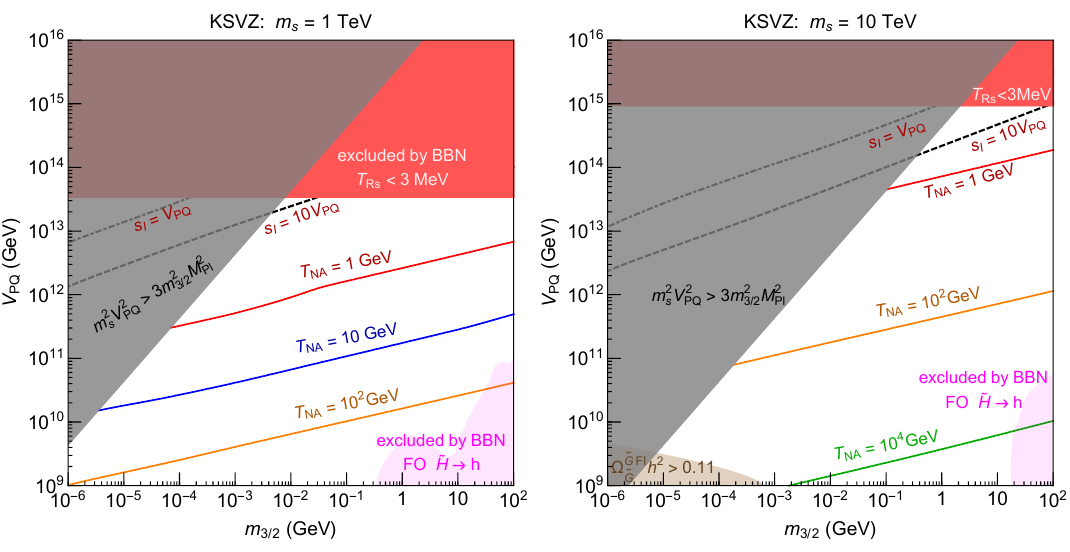
Figure 3 . Constraints on gravitino dark matter in KSVZ theories, with saxions decaying dom- inantly to gluons. In deriving the BBN constraint on freeze-out higgsinos, we take M 1 ; 2 1 TeV (6 TeV) for the left (right) panel. We set N DW = 1.